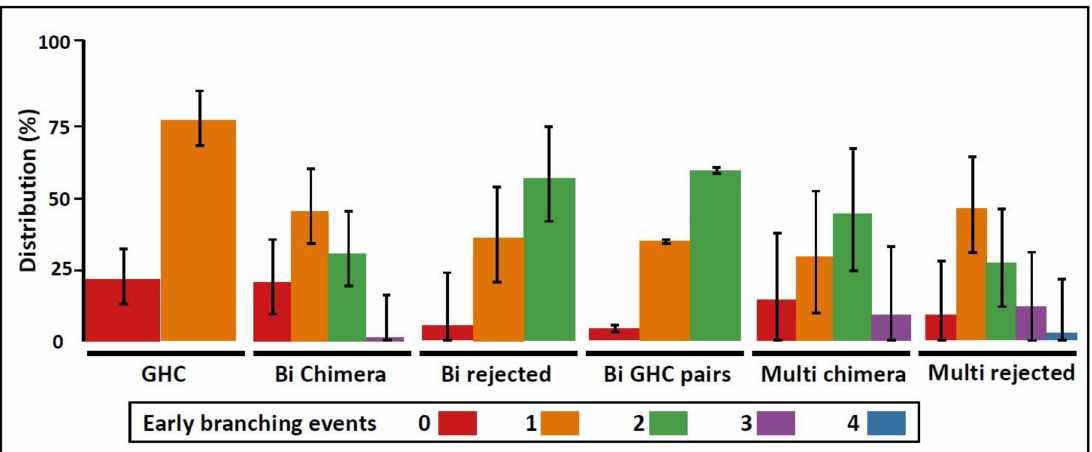
Figure 4. Distributions (%) of the colony early branching events in all S. pistillata colonial types. ‘Bi-GHC pairs’ are the permuted GHC pairs. The di ff erent branching events (0–4) are depicted by colors in the caption. Error bars are 95% confidence